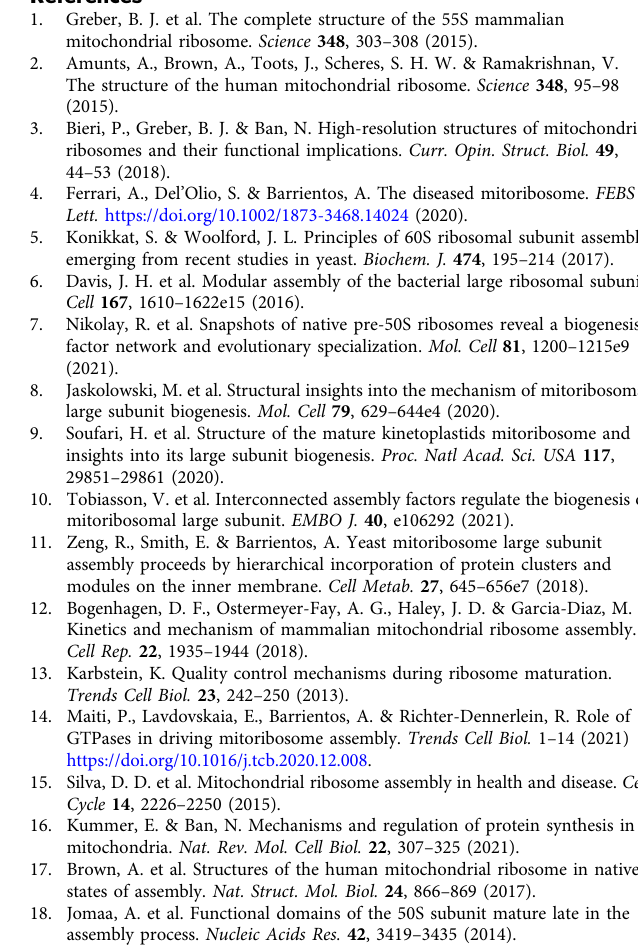
Figure preparation . Molecular graphics and analyses were performed with UCSF Chimera 44 and UCSF ChimeraX 53 , developed by the Resource for Biocomputing, Visualization, and Informatics at the University of California, San Francisco, with support from National Institutes of Health P41-GM103311 and R01-GM129325 and the Of fi ce of Cyber Infrastructure and Computational Biology, National Institute of Allergy and Infectious Diseases. Detailed views of cryo-EM map den- sities were created using The PyMOL Molecular Graphics System, Version 2.1.5 Schrödinger,